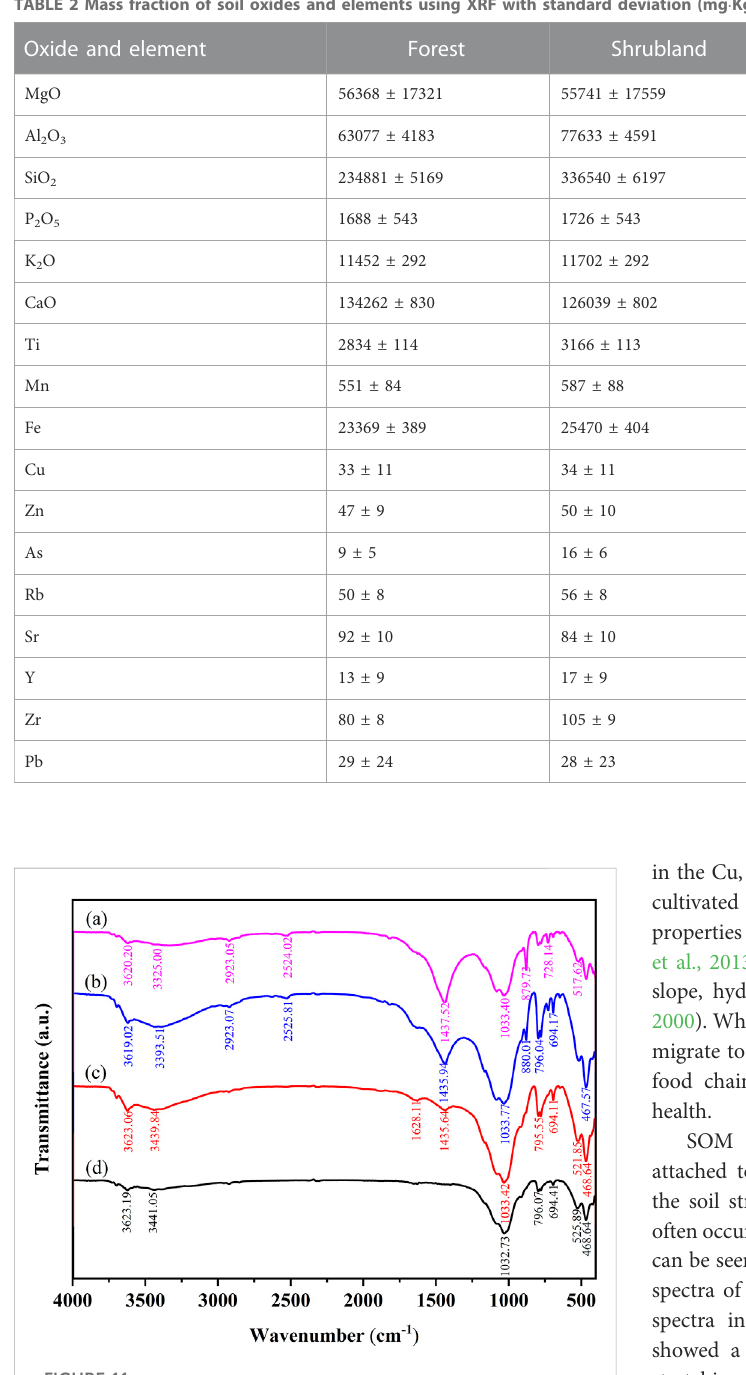
FIGURE 11 (A – D) represent the FTIR spectra of forests, shrublands, terraces, and cultivated land,